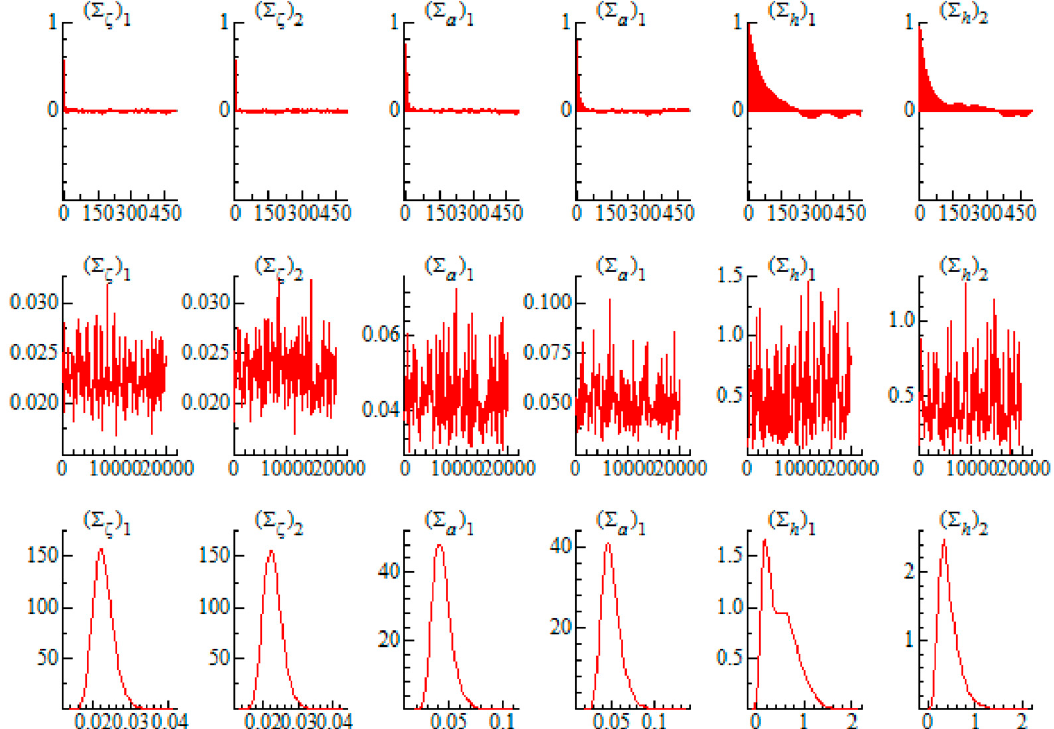
Figure 6. Estimation results of parameters in the TVP-VAR model (housing loans–housing prices).